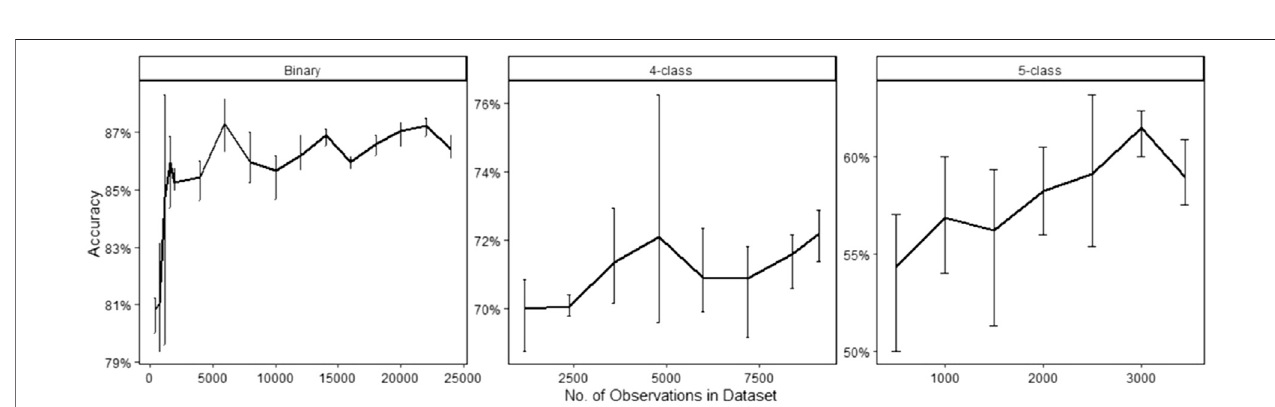
FIGURE 4 | Averaged testing accuracy as a function of number of observations used for each model. For each speci fi ed number of observations, three trials were conducted. The error bars represent the maximum and minimum errors.